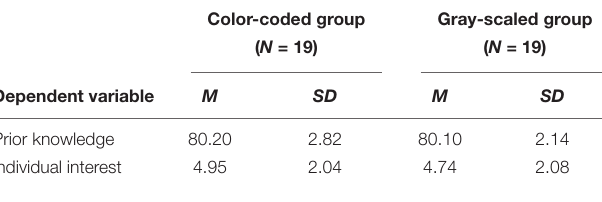
TABLE 1 | Means and standard deviations for control variables.